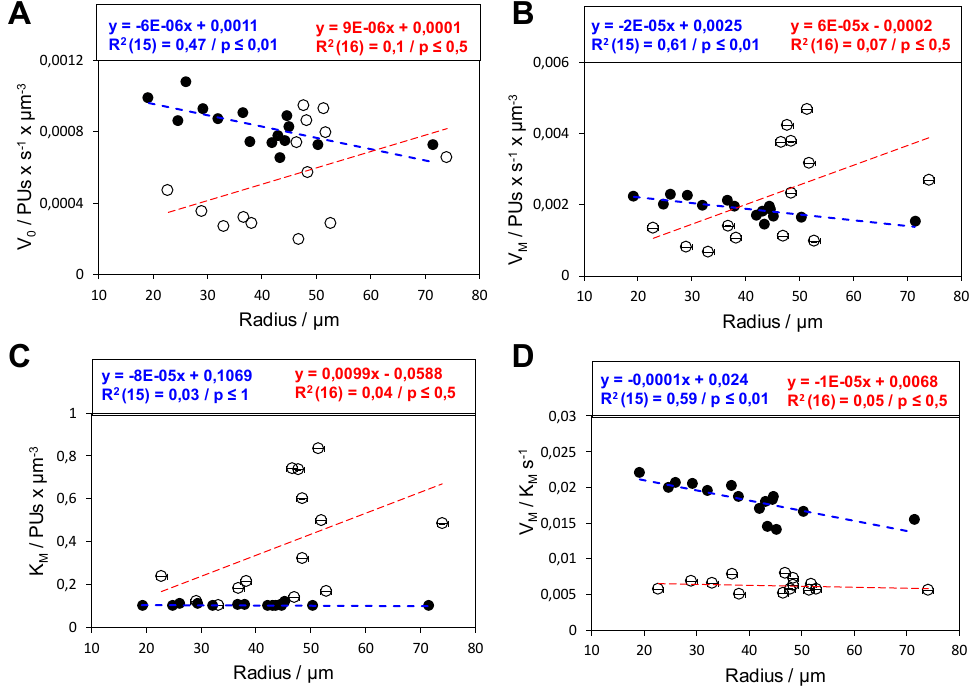
Figure 5. E ff ect of the particle radius on the kinetic parameters of the immobilized BsADH and NADH using either benzaldehyde (full circles) or acetone (empty circles) as substrate. For single particle analysis, apparent V 0 ( A ), V M ( B ), K M ( C ), andV M / K M ( D ) were determined and plotted against the radius of each particle (circles). The dashed lines represent the linear correlation between each kinetic parameter and the particle radius using benzaldehyde (blue) and acetone (red) as substrates. Linear regression equations are shown in the top boxes of each graph. The multiple correlation coe ffi cient R 2 and the p -value were calculated with an ANOVA statistical analysis and shown in blue and red for benzaldehyde and acetone, respectively. Number of samples is indicated in brackets beside the R 2